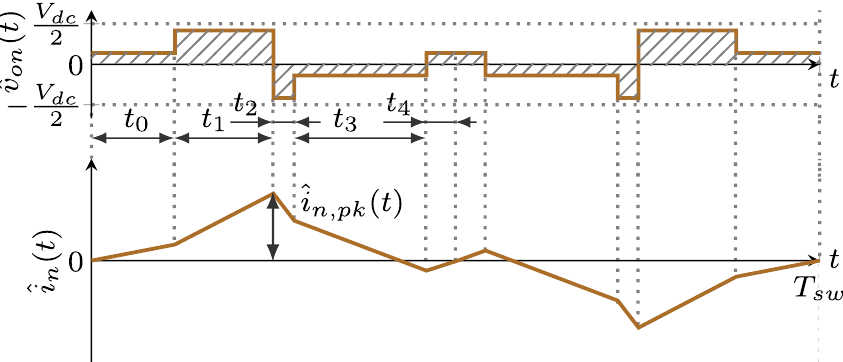
Figure 10. Voltage ripple component across the neutral line inductor (top) and neutral current ripple waveform in one switching period (bottom).